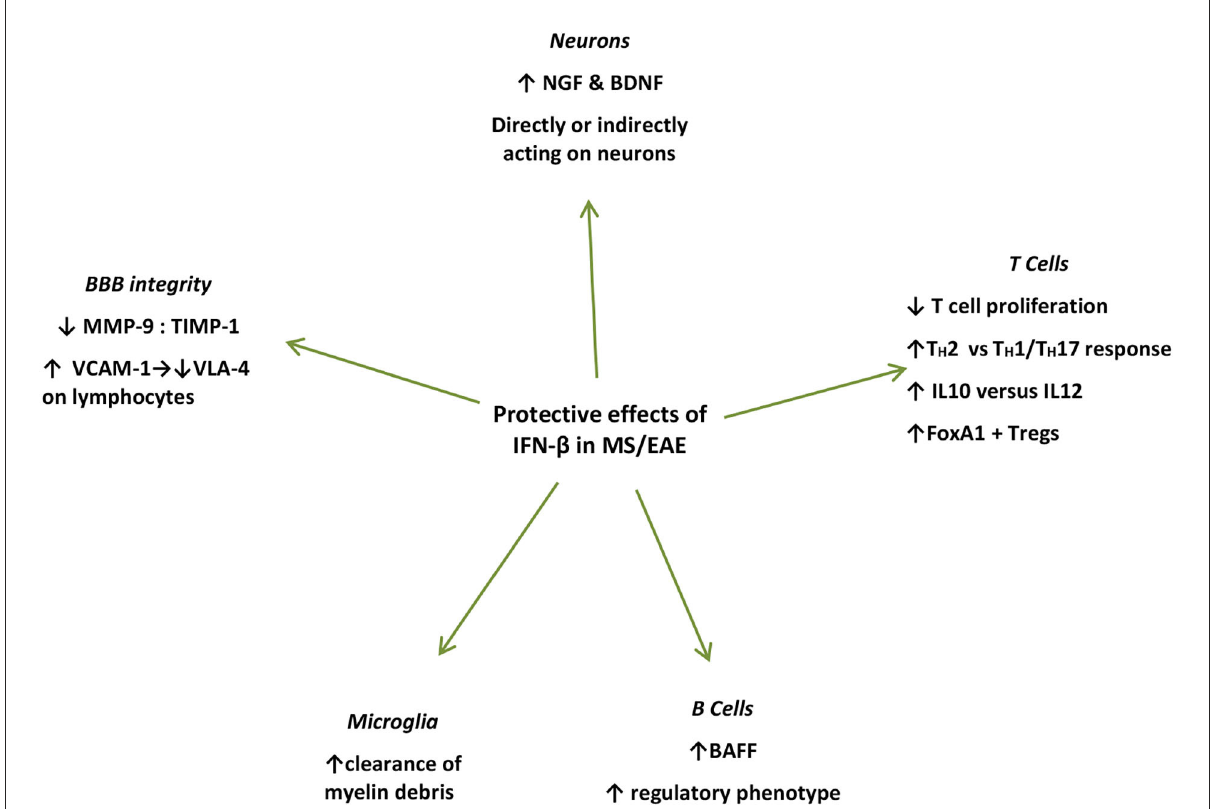
FIGURE2 Summary of protective mechanisms of action of endogenously produced or exogenously administered IFN- β during the effector phase of EAE/MS. IFN- β treatment induces NGF in astrocyte cultures (51), and in endothelial cells interacting with IFN- β -treated lymphocytes in vivo and in vitro (61) IFN- β further induces BDNF production (62). Microglial cells in close proximity to myelin debris produce IFN- β in EAE mice and in vitro (35). IFN- β treatment in MS patients induces BAFF and drives B cells toward a regulatory phenotype (63). IFN- β inhibits T-cell proliferation (64), and recombinant IFN- β administered to RRMS patients is associated with increased proliferation of Foxp3 + Tregs as well as FoxA1 + Treg cells (65–67). IFN- β favors Th2 over Th1 responses (66). IFN- β treatment in MS patients leads to increased levels of soluble VCAM1 in their serum leading to a decrease in VLA-4 expression on lymphocytes, interfering with their capacity to bind endothelial cells thereby preventing their diapedeses through the BBB (68). IFN- β further prevents the erosion of the BBB by reducing MMP-9 or by increasing levels (69–71). IFN, interferon; CNS, central nervous system; NGF, nerve growth factor; BDNF, brain-derived neurotrophic factor; BAFF, B-cell activation factor; Treg, regulatory T cells; VCAM-1, vascular cell adhesion molecule-1; VLA-4, very late antigen 4; MMP-9, matrix metalloprotease 9; TIMP-1, TIMP metalloprotease inhibitor